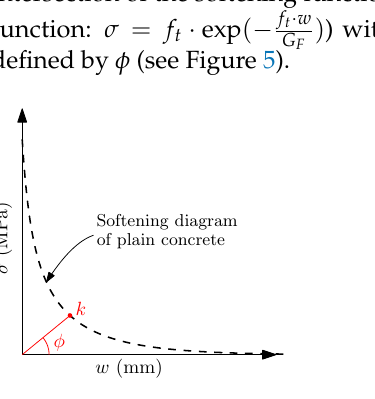
Figure 5. Identification of k point of the trilinear diagram by means of the angle φ